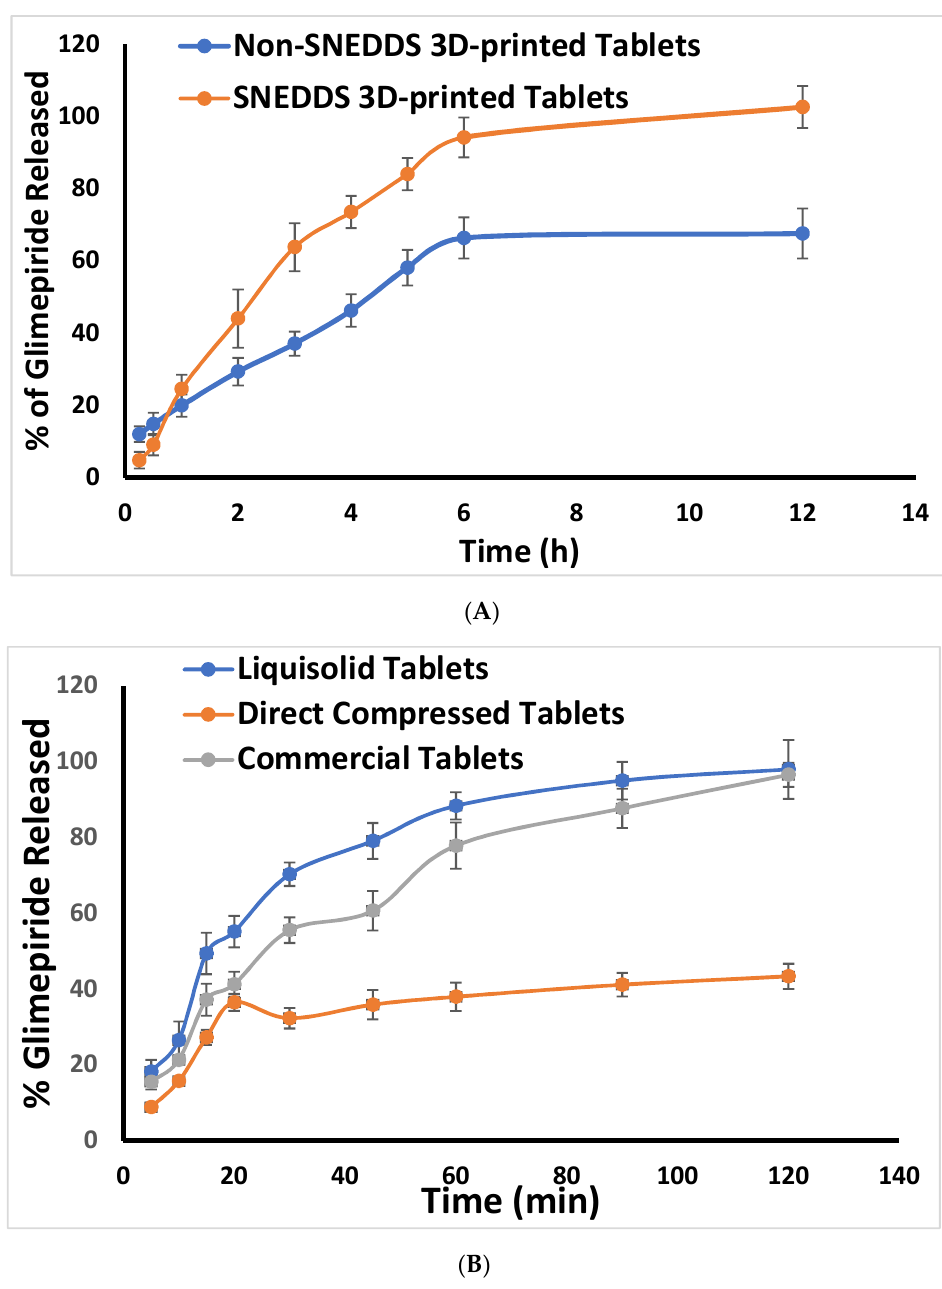
Figure 2. In vitro release of glimepiride from; ( A ) the prepared 3D-printed tablets, ( B ) the liquisolid, direct compressed and commercial tablets.